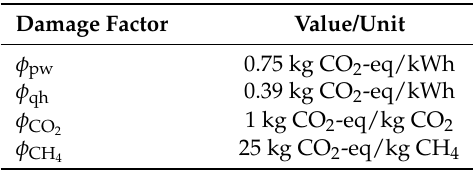
Table 4. Parameters used to assess the global-warming potential of the superstructure shown in Figure 1